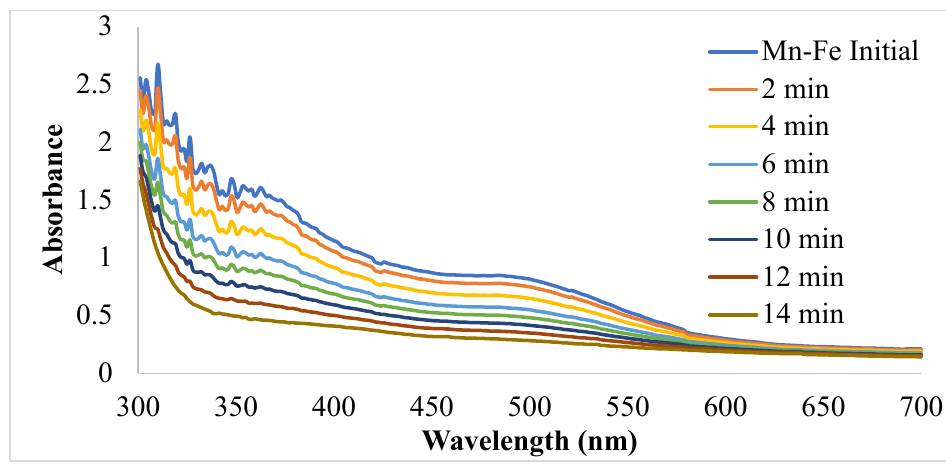
Figure 12. UV-visible spectra for photocatalytic degradation of CR using Fe-Mn NPs.